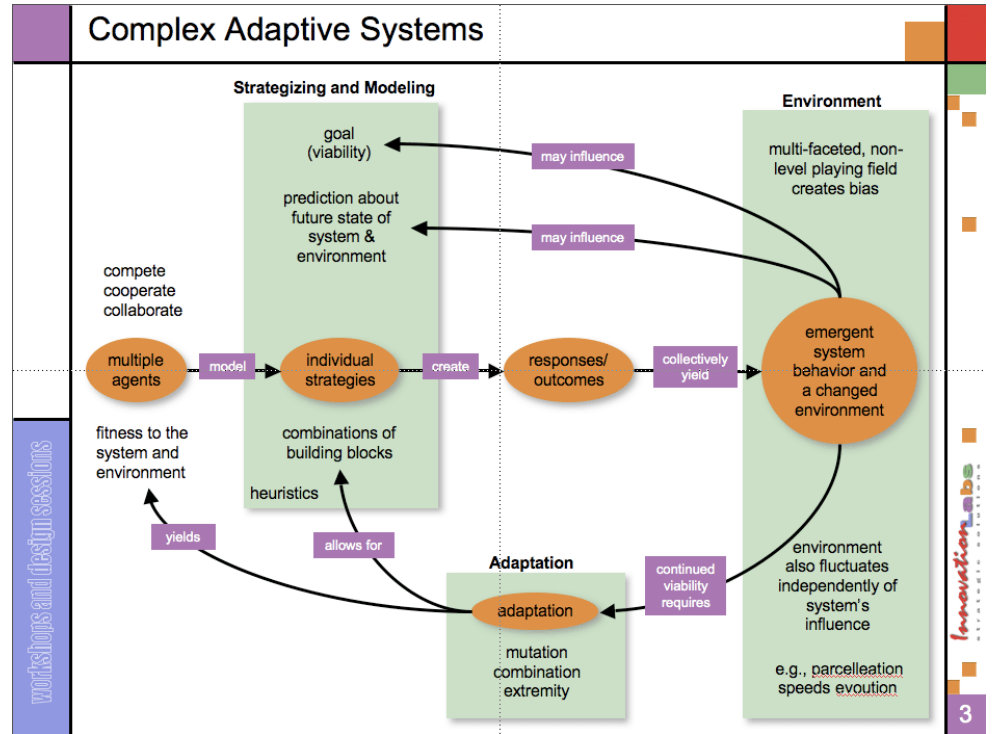
Figure 1. Illustration of a Complex Adaptive System (Innovation Labs Strategic Solutions,